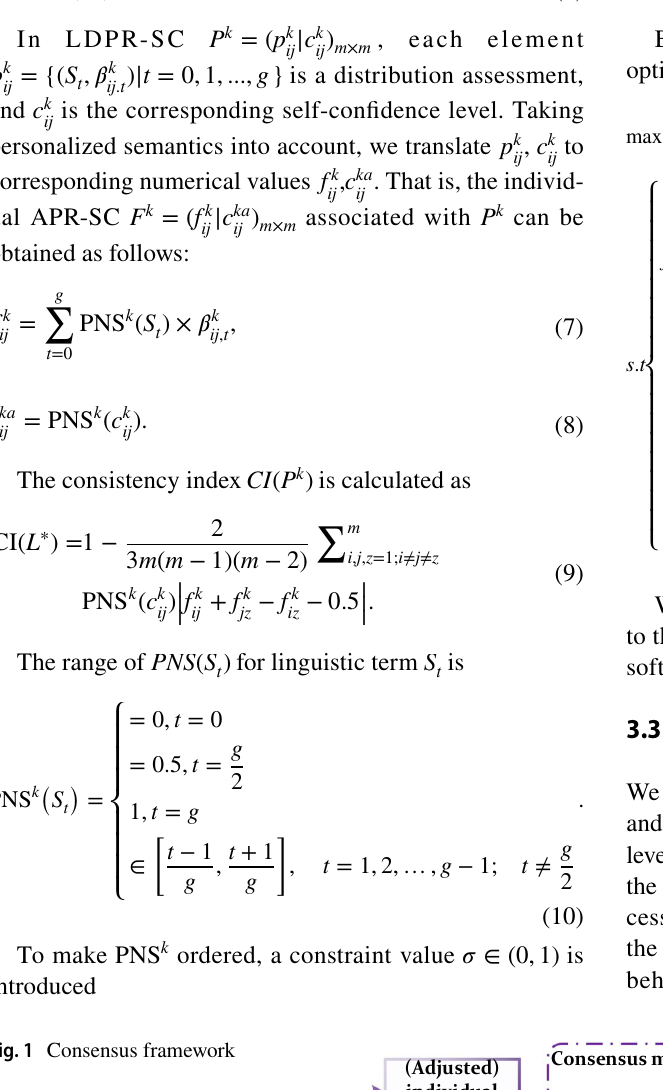
Feedback adjustment